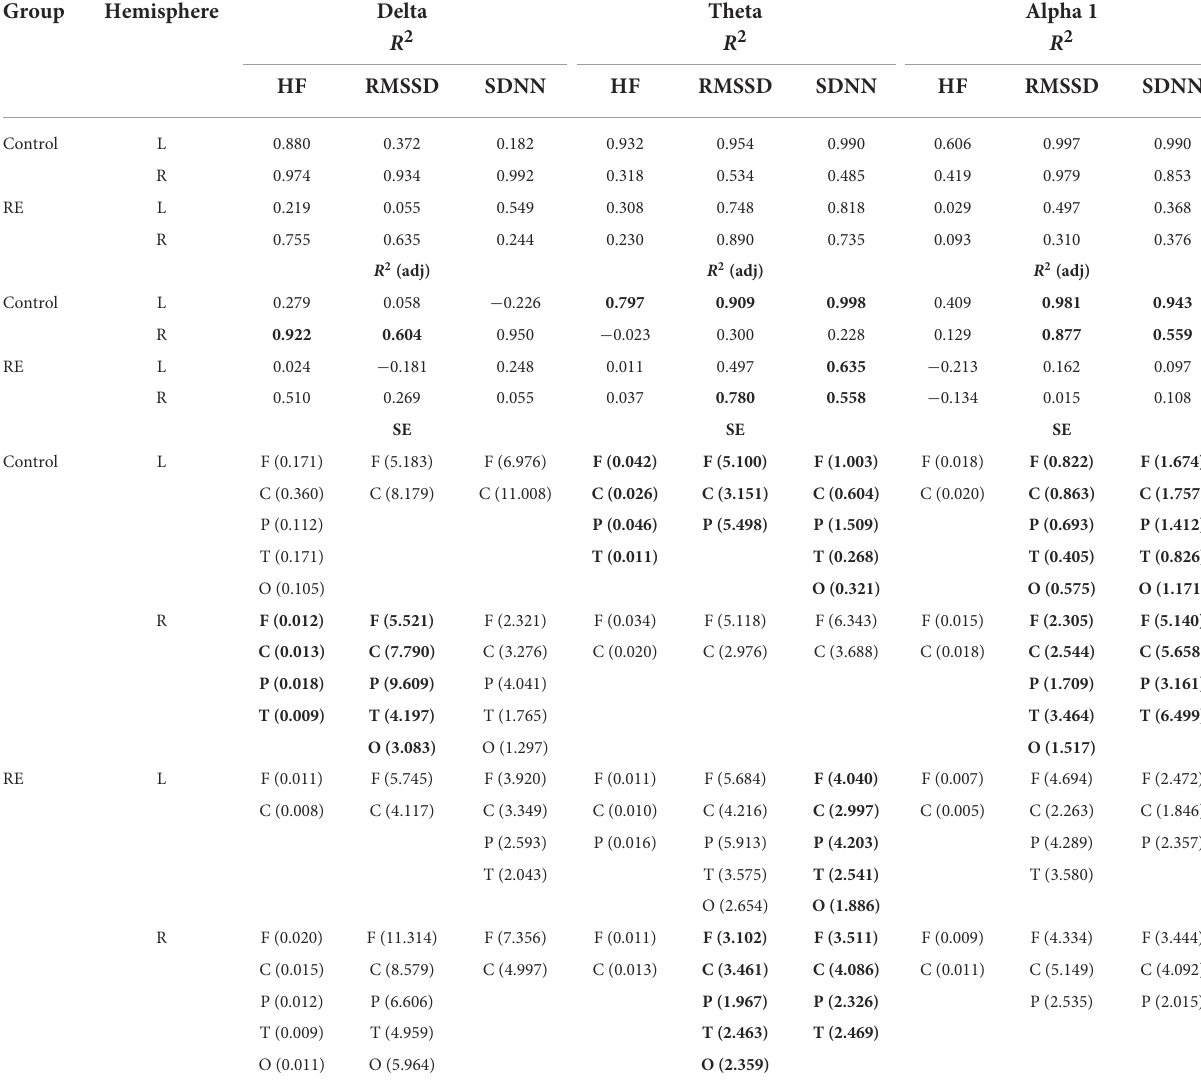
TABLE 4 Multiple regression parameters for the HRV variables as a function of EEG power (delta, theta, and alpha 1). Group